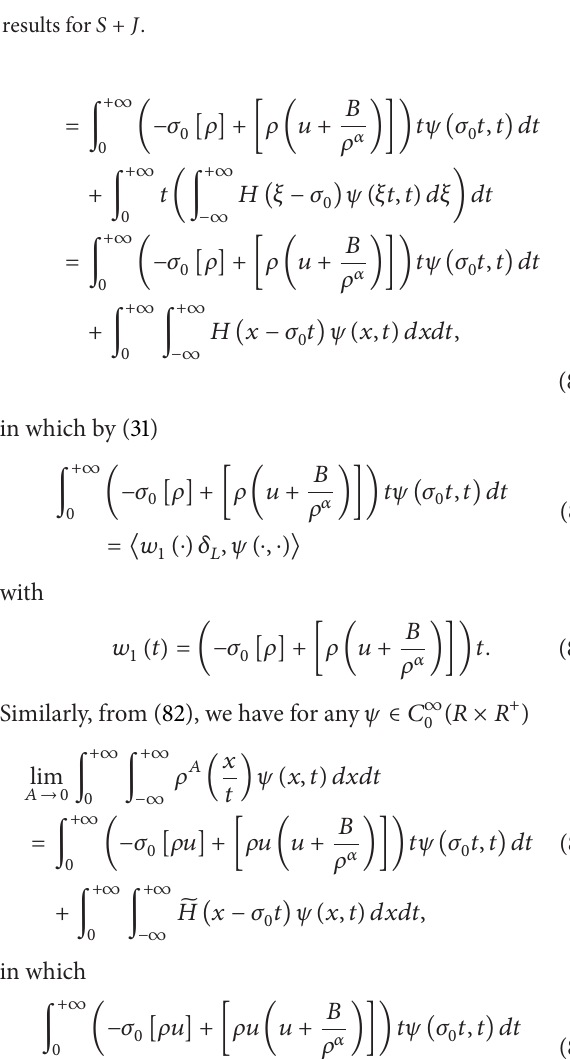
Figure 4: Numerical results for 𝑆 + 𝐽